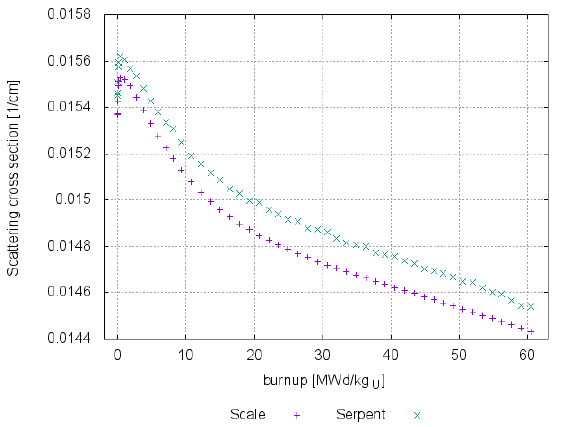
Figure 7. Scattering cross-section from fast group to thermal group, dependency on burnup.